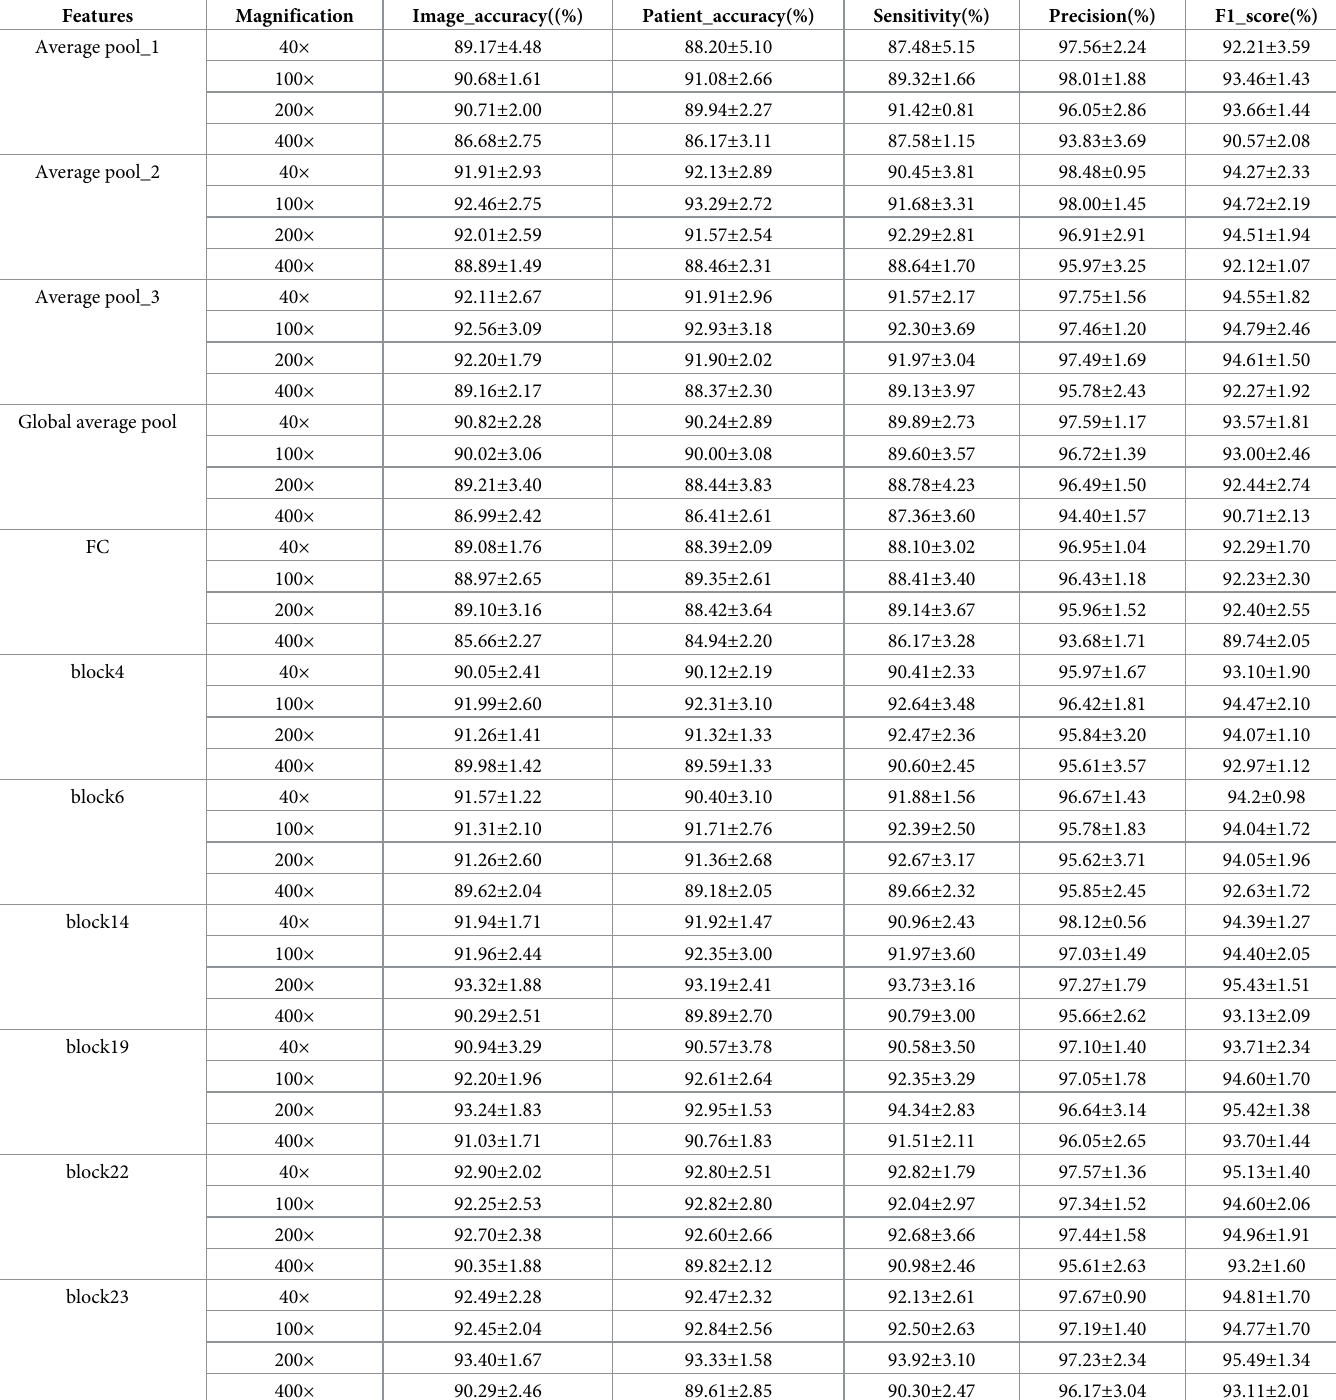
Table 2. Classification performance of different deep layer